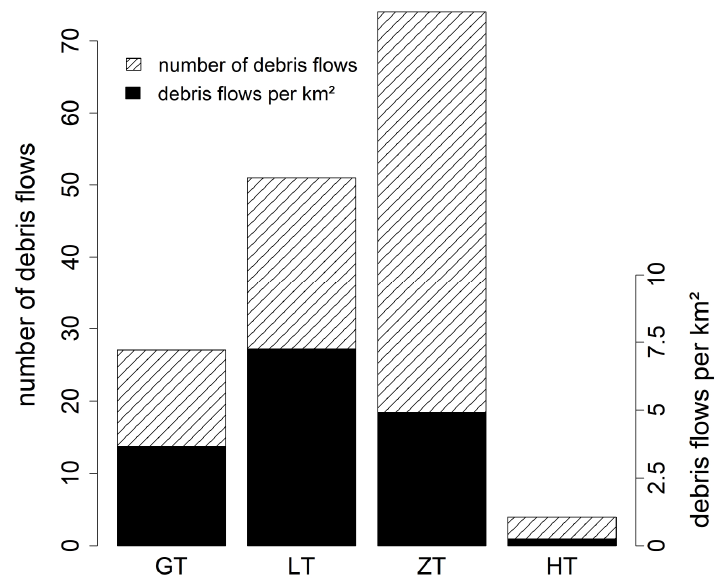
Figure 11. Number of debris flows per sub-catchment as well as the normalised debris flow count per square kilometre for the respective sub-catchments.